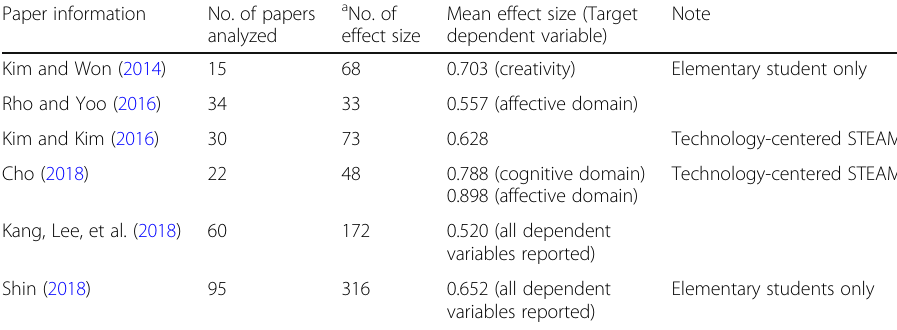
Table 2 An overview of meta-analysis studies Paper information